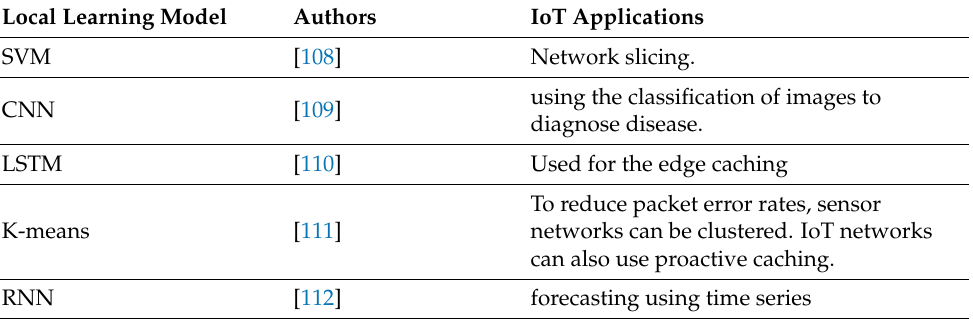
Table 10. IoT local learning